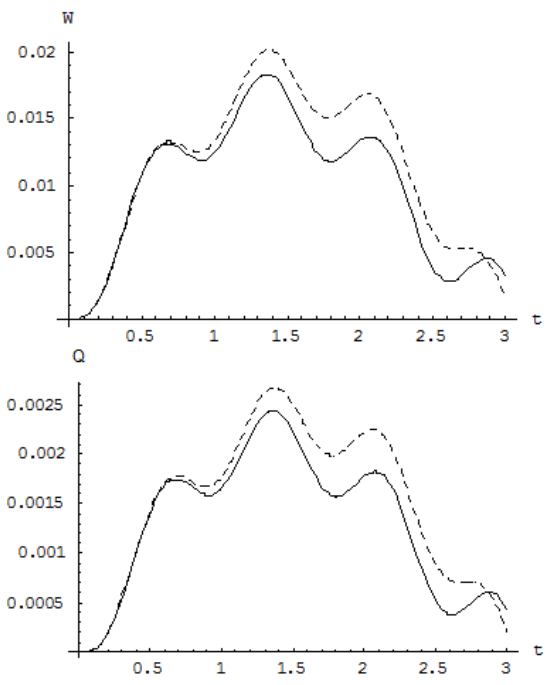
Figure 18: The influence of the load model for R = 150 m and υ = 20 m/s and ( - - - ) Concentrated load P = Mg , ( ___ ) Damped mass- load M .